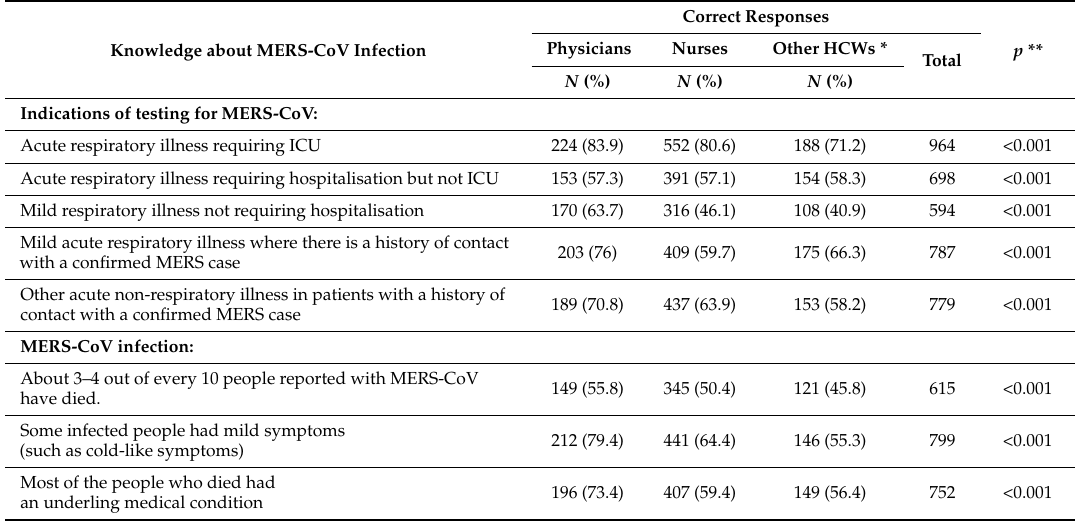
Table 2. Health care workers (HCWs)’ knowledge about MERS-CoV